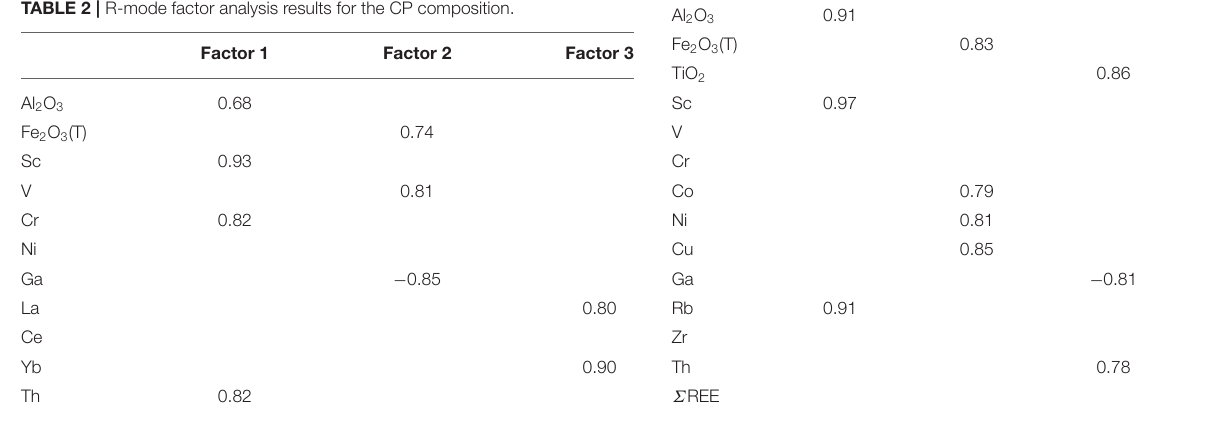
TABLE 2 | R-mode factor analysis results for the CP composition.